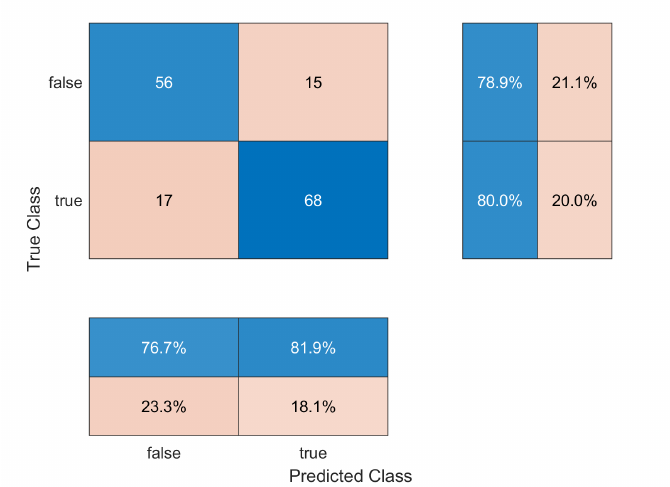
Figure 7. Confusion matrix (Lithuanian voice dataset).